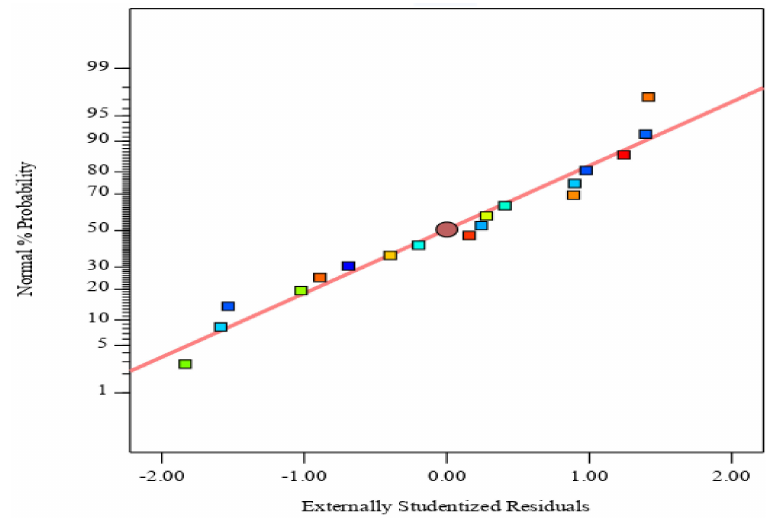
Figure 11. Plot of the normal probability of the linear model. A plot of the externally studentized residuals versus the predicted values was used to assess the assumption of homoscedasticity (equal variance). In other words, linear regression assumes that the variance in the residual versus predicted value plot is constant, with a symmetric shape. Therefore, a symmetrically shaped distribution of errors around the zero in the scatter plot indicates homoscedasticity, while asymmetric shapes in the scatter plot are heteroscedastic. The asymmetric shapes in the scatter plot indicate that the linear model is not suitable. Figure 12 shows that the predicted values versus residual values are distributed around zero in a symmetric shape. Thus, the linear model was suitable to predict the accumulated strain of the warm mix asphalt.